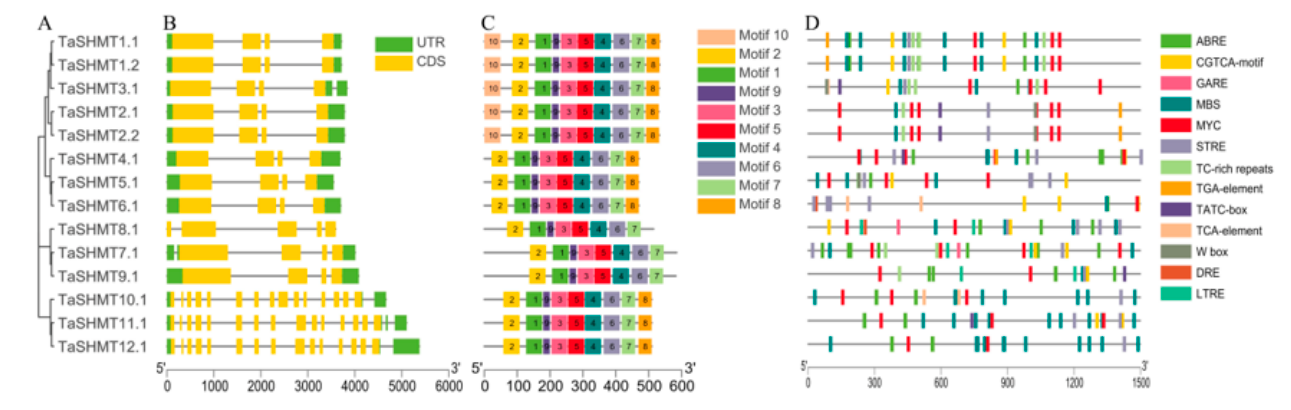
Figure 4. Phylogenetic classification ( A ), exon–intron structures ( B ), conserved domains ( C ), and cis -elements ( D ) analysis of TaSHMT genes. ( B ) Green boxes, yellow boxes, and black lines indicated UTR, exons, and introns, respectively. ( C ) Conserved domain compositions of TaSHMT proteins in wheat. Motif 1 to motif 10 are shown in the different colors. ( D ) Hormone and stress-responsive elements are shown by different colors.